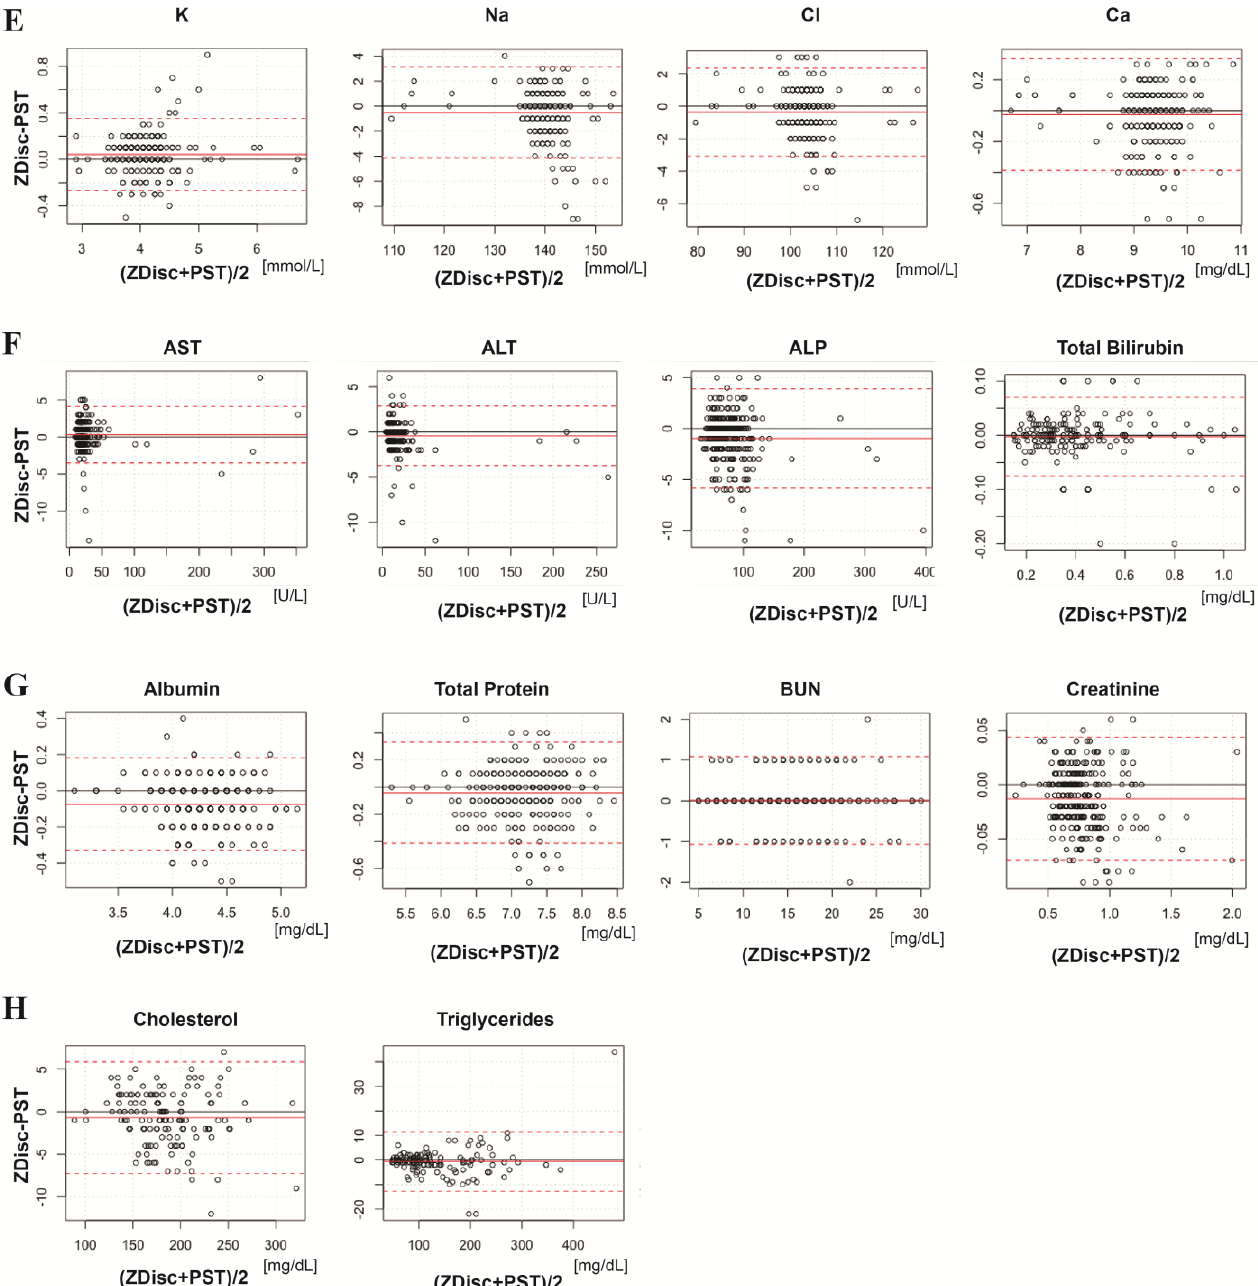
Figure 2. Scatter plots representing all 14 analytes results for ZDisc vs. vacutainer PST with Deming regression line with 95% CI (blue), reference interval for each analyte (orange), and identity line (red dots) across all sites and analyzers ( A – D ); Bland–Altman plots with mean (red solid line) and +/−2*SD (red dotted line) ( E – H ). Table 2. Mean percent bias for all analytes at each site and for each chemistry analyzer.